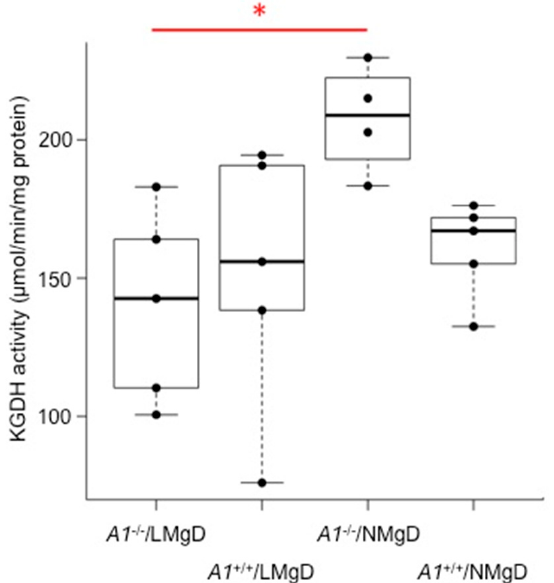
Figure A4. Post-hoc Tukey’s range test/ICDH. The ICDH activities presented as box-and-whisker plot overlaid with dot plot; dots represent raw input values for each analyzed group ( Slc41a1 − / − animals on LMgD, Slc41a1 +/+ animals on LMgD, Slc41a1 − / − animals on NMgD, and Slc41a1 +/+ animals on NMgD); ** p < 0.01, *** p < 0.001. Abbreviations: A1 , Slc41a1 ; ICDH, isocitrate dehydrogenase; LMgD, low Mg diet; NMgD, normal Mg diet.